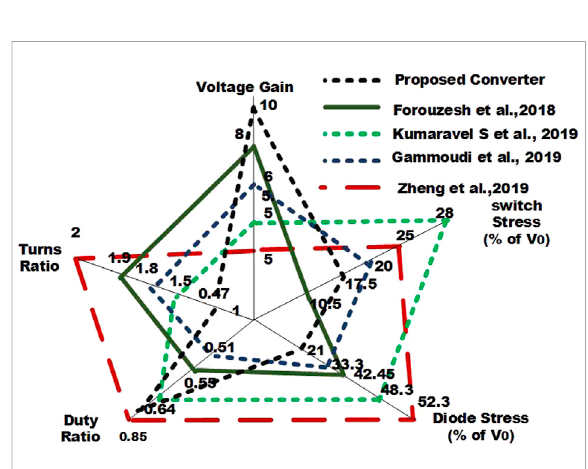
FIGURE 13 Proposed converter ’ s output voltage, output current, input voltage, and input capacitor current.